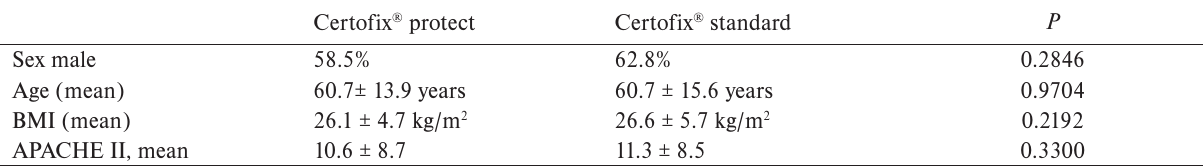
Table 1. Patient baseline data in the Certofix ® protect and Certofix ® standard group. Certofix ® protect Certofix ® standard